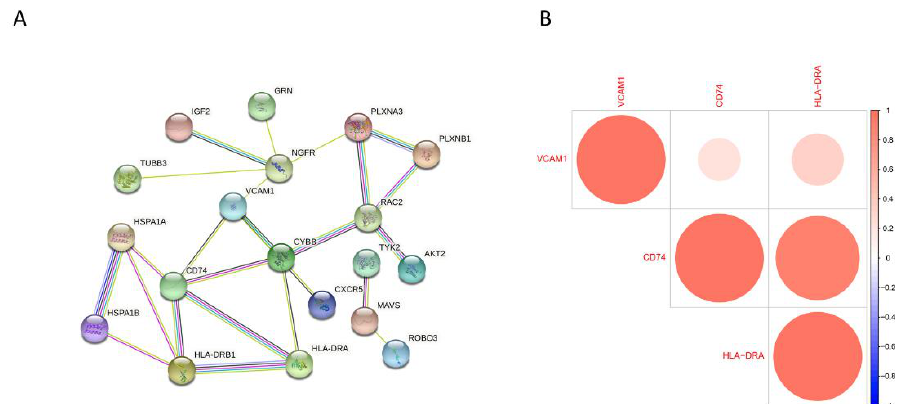
Figure 7. ( A ) The PPI network for the 3 hub genes. ( B ) The interaction between 3 potential bi- omarkers.